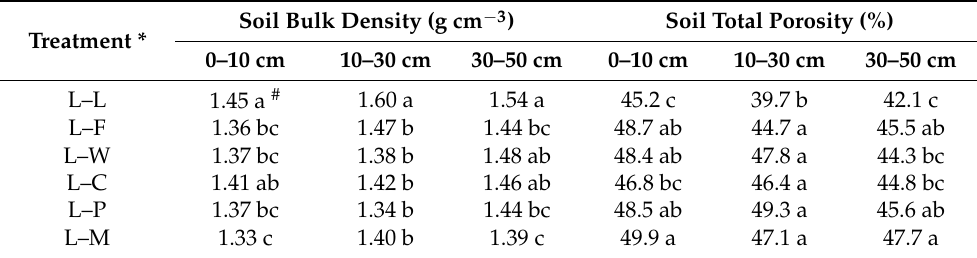
Table 3. Soil bulk density and soil total porosity of the crop rotation treatments in October 2015.